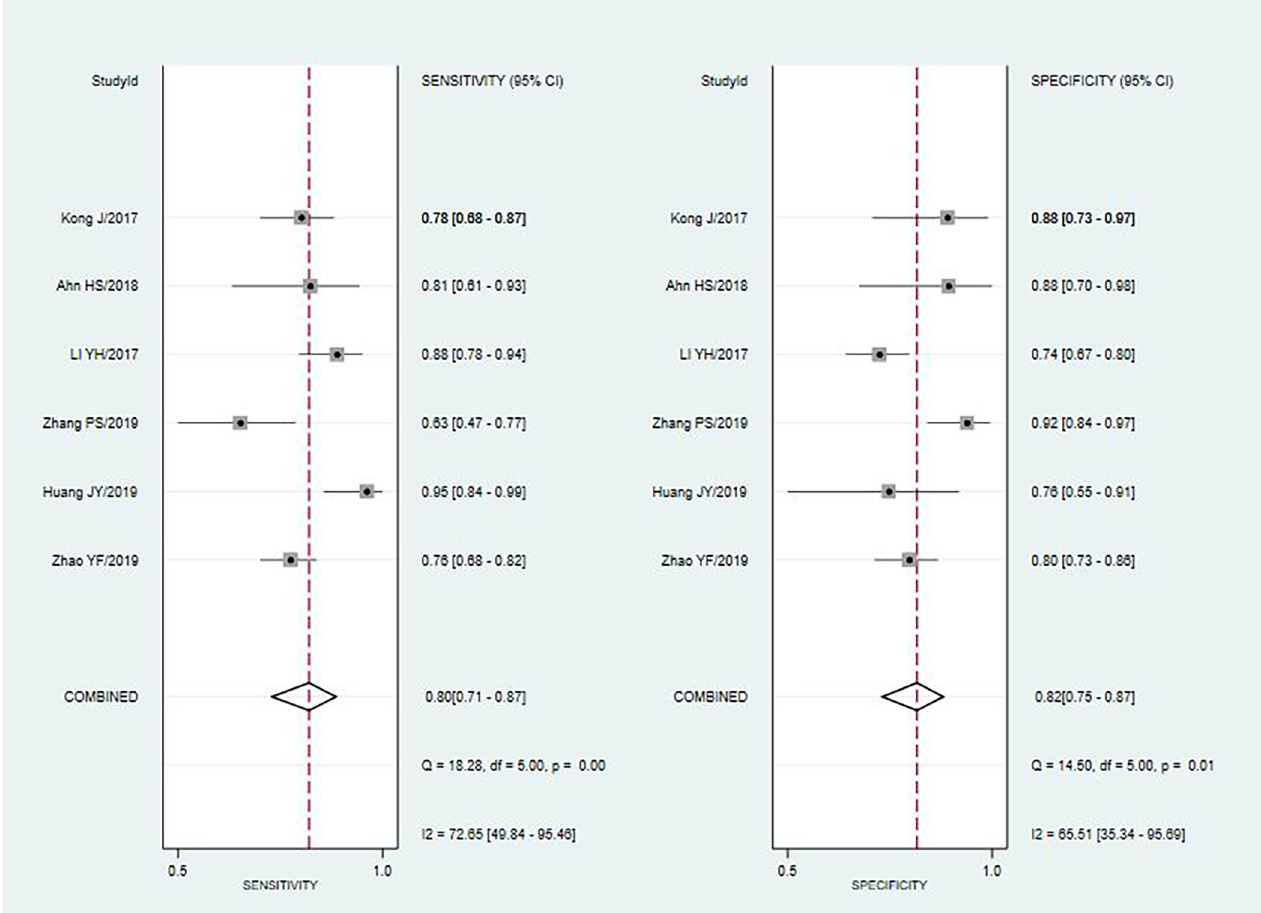
Fig 2. Forest plots for the accuracy of TI-RADS for the diagnosis of thyroid nodules.